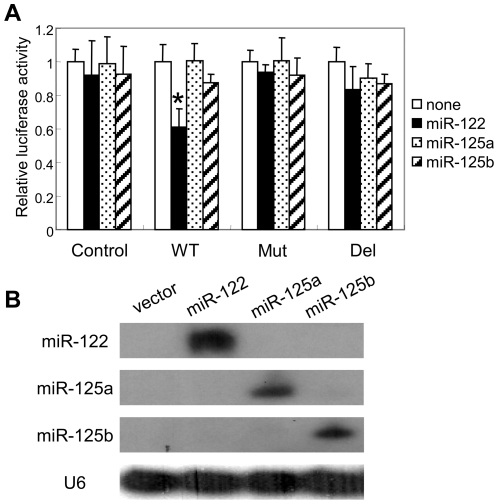
Effect of miR-122 on Nocturnin reporter expression is specific.
A. Relative luciferase activities (means ± S.E. Two independent experiments in triplicate) when reporter genes were co-transfected with either miR-122, miR-125a, or miR-125b in NIH3T3 cells. Asterisks represent p<0.005 miR-122 versus no miR-122, miR-125a, or miR-125b. B. Northern blot analysis of miRNAs. Same amount of plasmid DNA (1 µg) to express miR-122, -125a, and -125b was transfected into HEK293 cells.